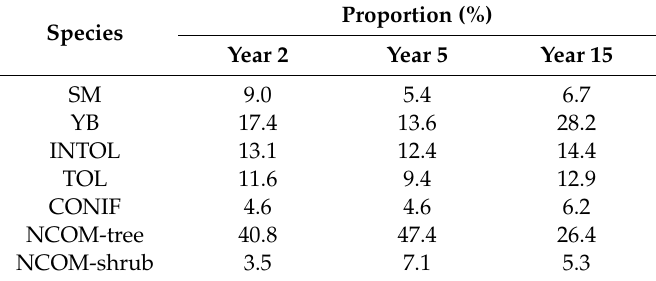
Table 6. Proportion of quadrats dominated by a given species, per year. Values are derived from data presented in Table 5. See Table 1 for species’